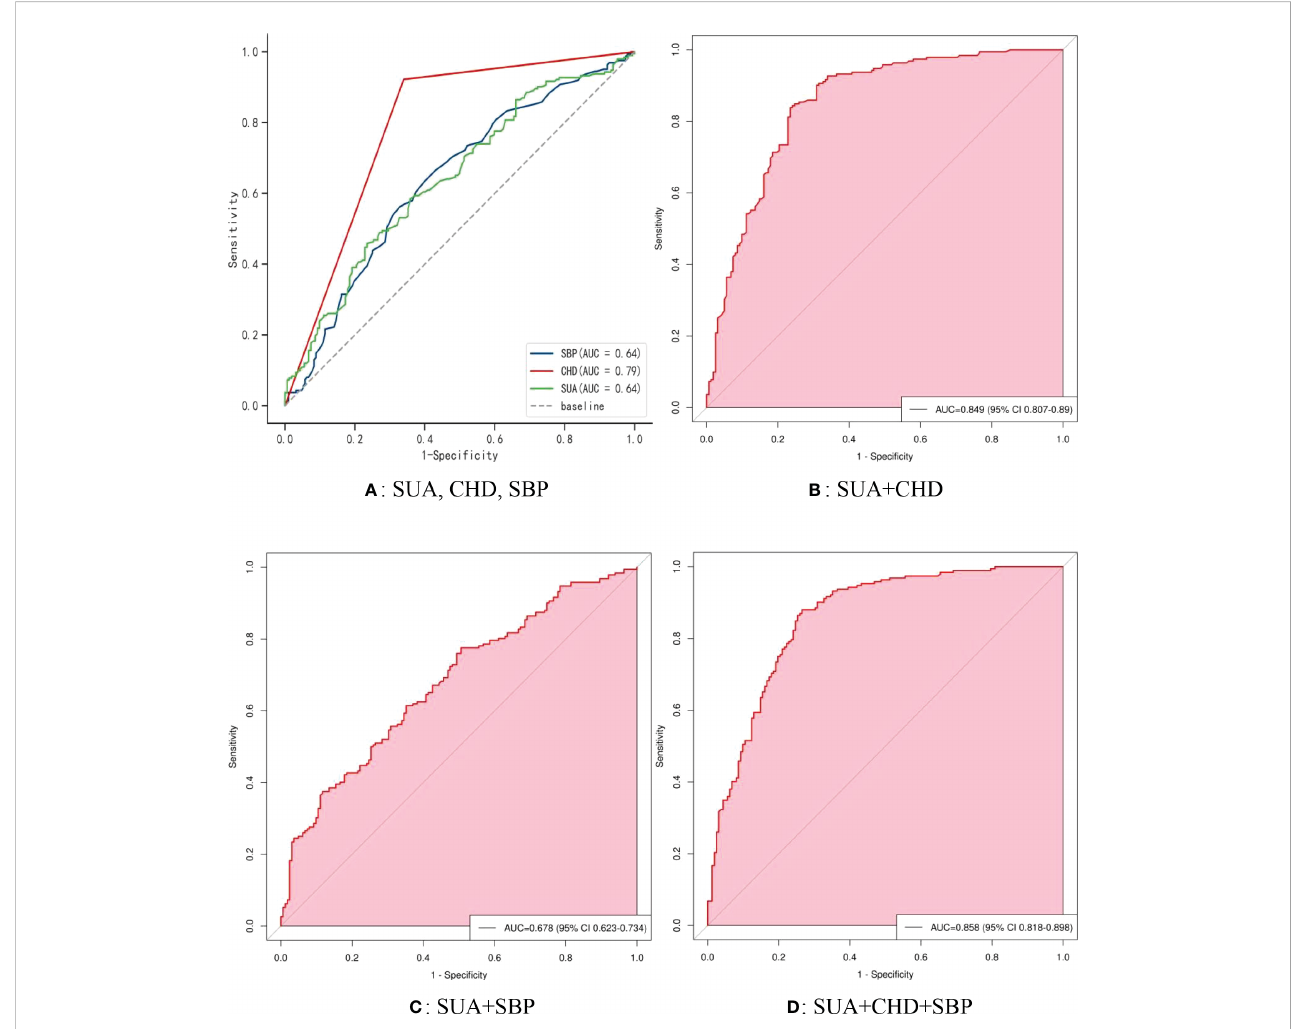
FIGURE 7 The receiver operating characteristic (ROC) curve model of SUA for diagnosing AF in the DM pattern. (A) Performance of SUA, CHD, and SBP for predicting AF. (B) Performance of SUA combined with CHD for predicting AF. (C) Performance of SUA combined with SBP for predicting AF. (D) Performance of SUA combined with CHD and SBP for predicting AF. DM, diabetes mellitus; SUA, serum uric acid; CHD, coronary heart disease; APOB, apolipoprotein B; SBP, systolic blood